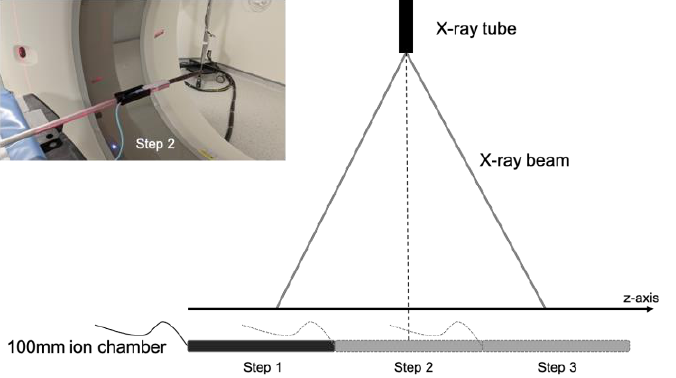
Figure 3. Diagram representation of the recommended three-step in-air measurement method of 𝐶𝑇𝐷𝐼 𝑎𝑖𝑟,𝑁×𝑇>40 for beam width 𝑁 × 𝑇 larger than 40 mm with a 100 mm CT chamber.